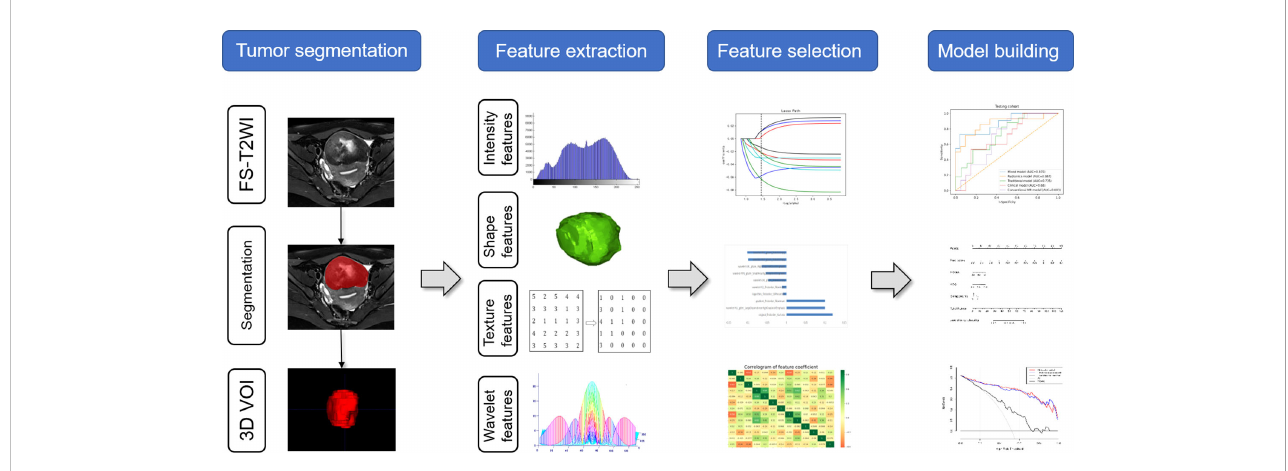
FIGURE 2 Process of radiomics analysis in this